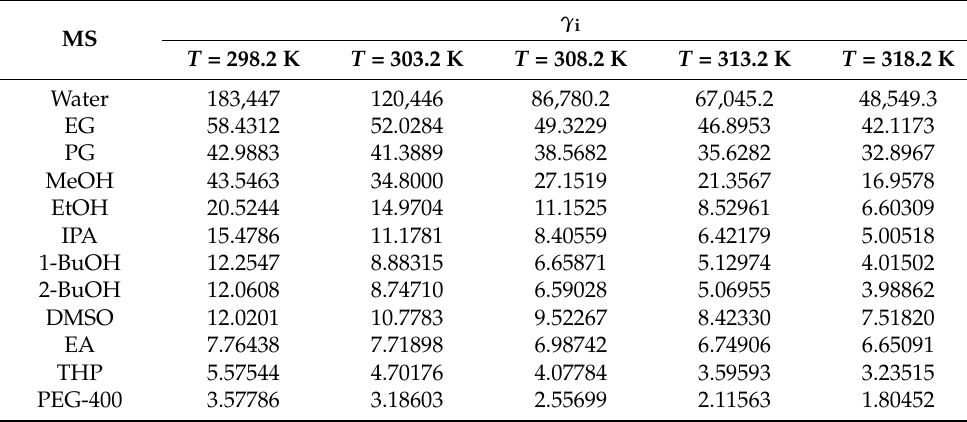
Table 3. Activity coefficients ( γ i ) of FBX in several MS at 298.2–318.2 K.